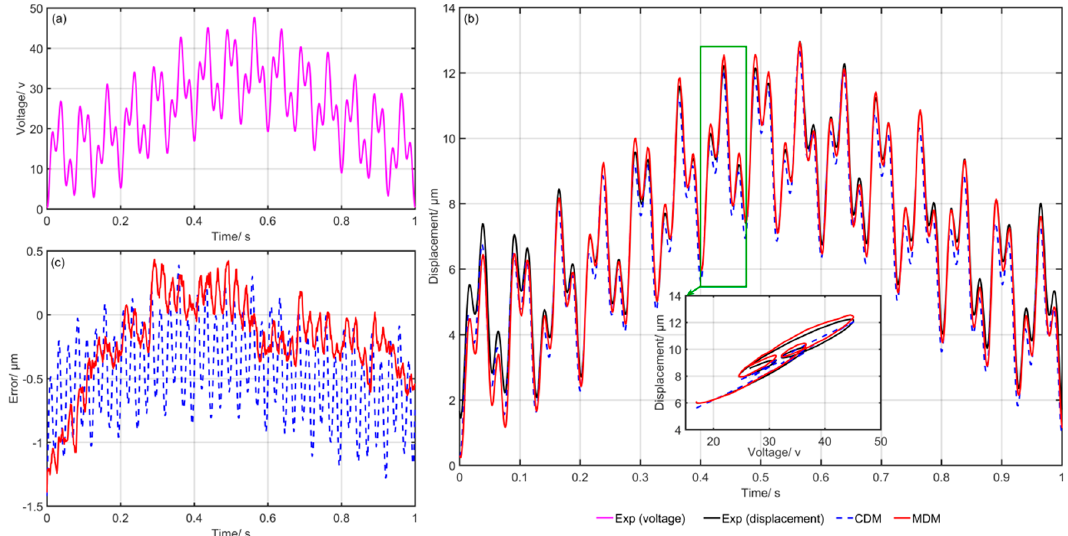
Figure 7. Exp2: Comparison of the experimental and simulation results of the CDM and MDM under u 2 ( t ) = 10sin ( 2 π · t ) + 8sin ( 2 π · 15 t ) + 6sin ( 2 π · 40 t ) + 24: ( a ) Time histories of input voltage, ( b ) time histories of output displacements and ( c ) time histories of errors of the CDM and MDM.